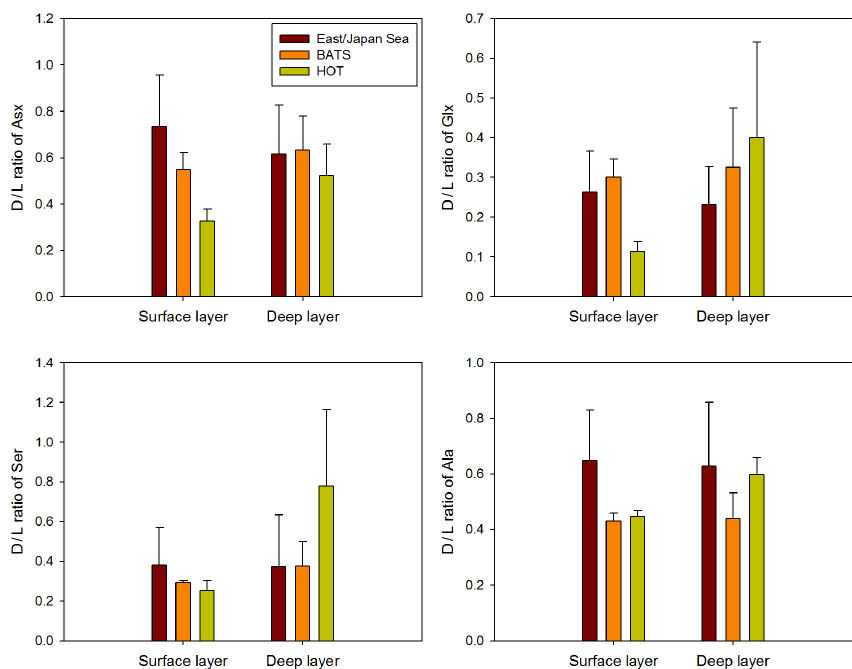
Figure 6. Average D:L ratios of asparagine + aspartic acid (Asx), glutamine + glutamic acid (Glx), serine (Ser), and alanine (Ala) from surface (0–200m) and deep ( ≥ 1000m) layers in the East/Japan Sea, BATS, and HOT. Error bars represent standard deviations.